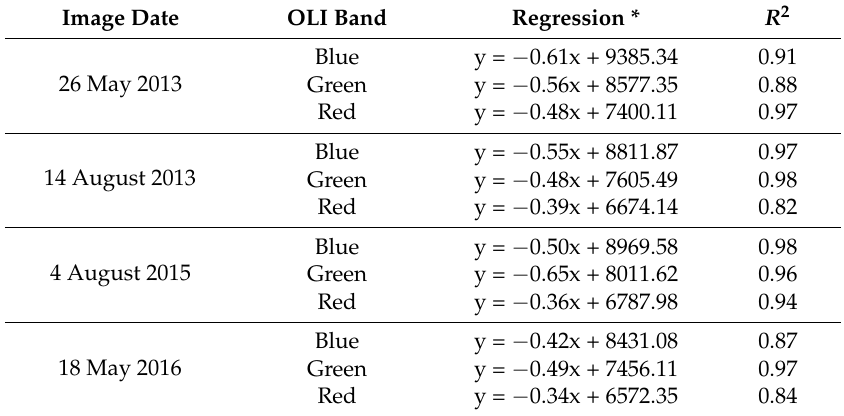
Table 3. Linear regressions of MIN DN on elevation for three visible bands of four Landsat OLI sub-images.